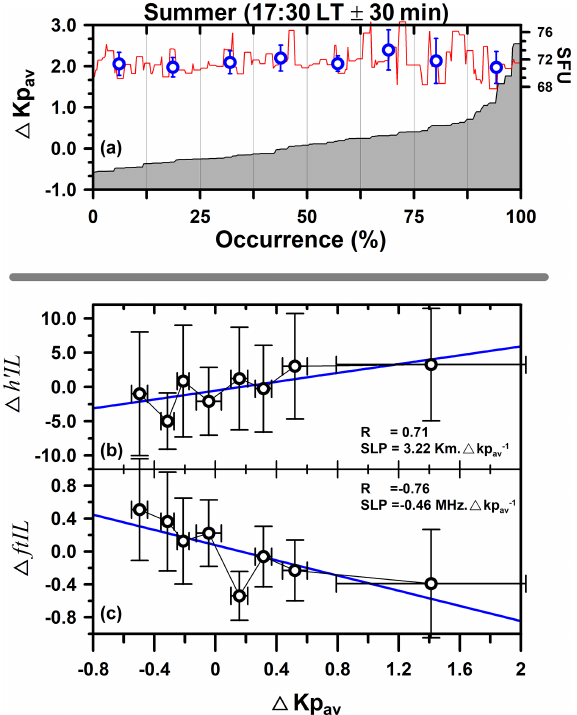
Figure 5. Responses of the intermediate layer to the geomagnetic activity for summer at 17:30LT ± 30min. (a) shows the (cid:49) Kp av data organized from the lowest to the highest values and divided into eight sections with the same percentage of samples. In addition, the values of F10.7P with respect to (cid:49) Kp av and the average of the F10.7P (blue open circles) for each section are also presented. (b) and (c) show the linear regression fitting over the height and fre- quency residual variability relative to the average (cid:49) Kp av